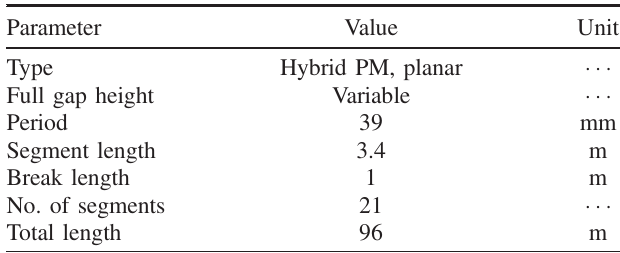
TABLE II. Parameters of the LCLS-II soft x-ray